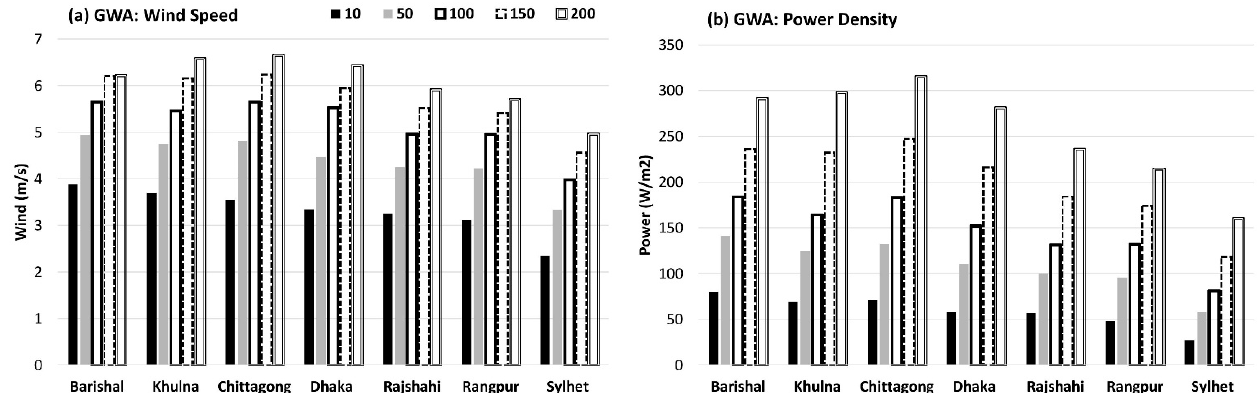
Figure 6. From GWA representing average ( a ) wind speed (m/s) at various heights (m) and ( b ) power density (W/m 2 ).